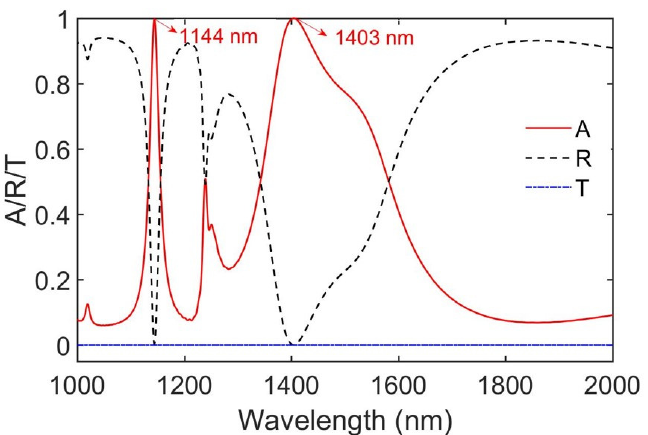
Figure 3. The absorptivity (A), reflectivity (R), and transmissivity (T) of the proposed structure under the normal incidence.